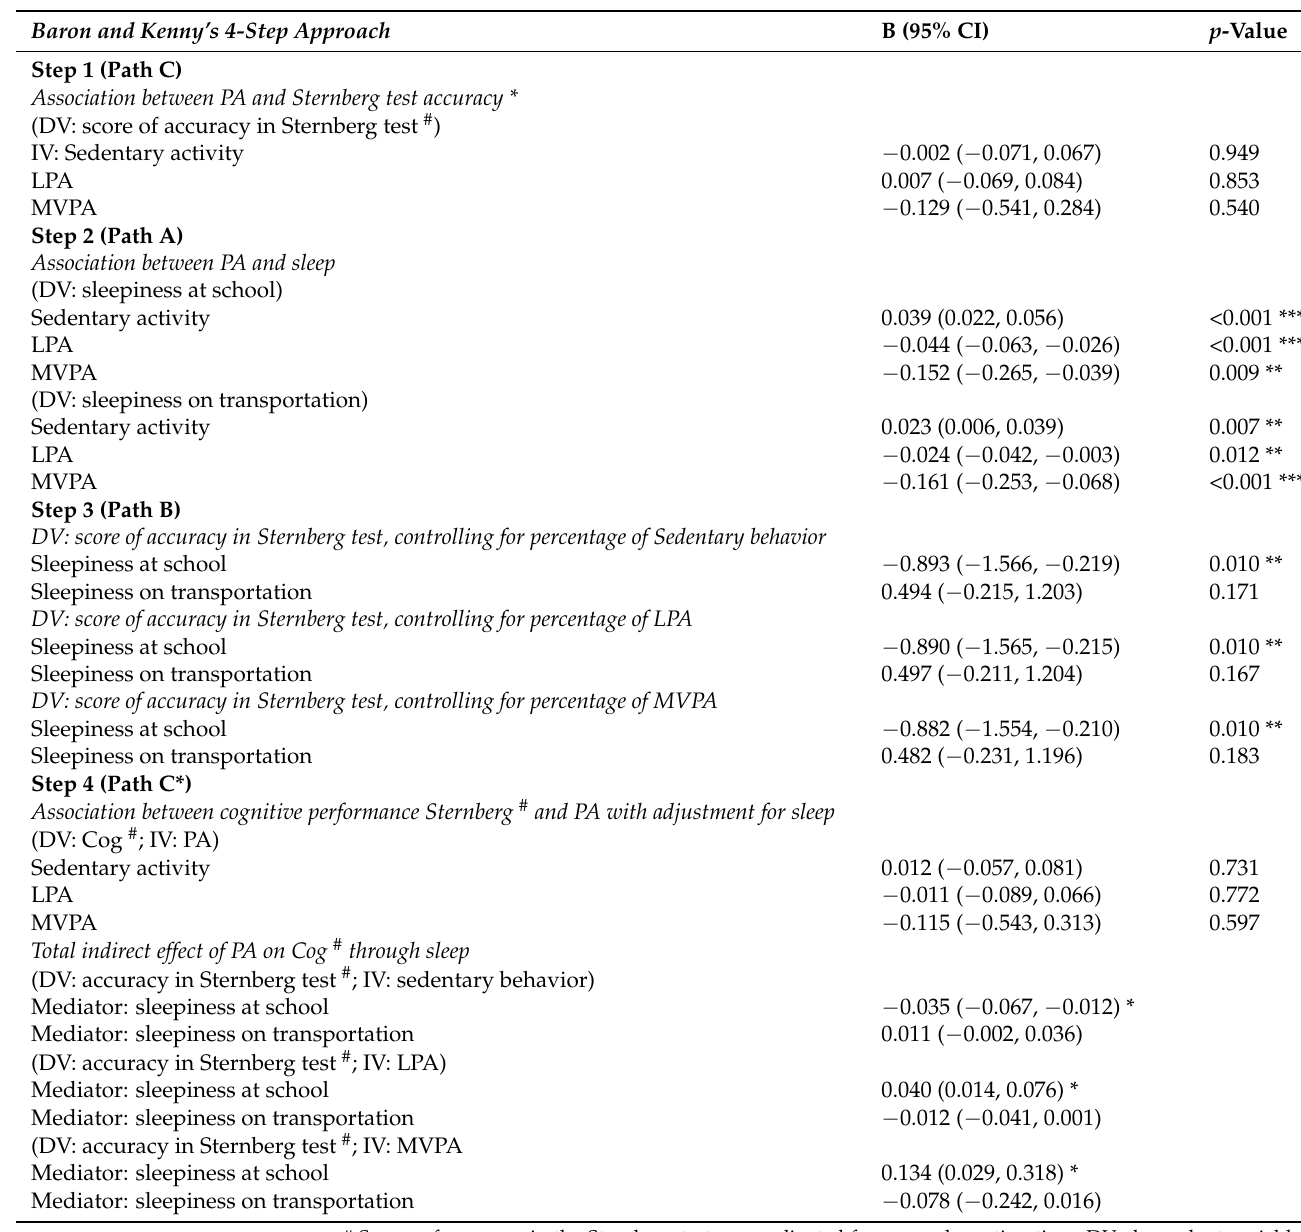
Table 2. Regression analyses examining the mediating effects of sleepiness on the association between physical activity and Sternberg test